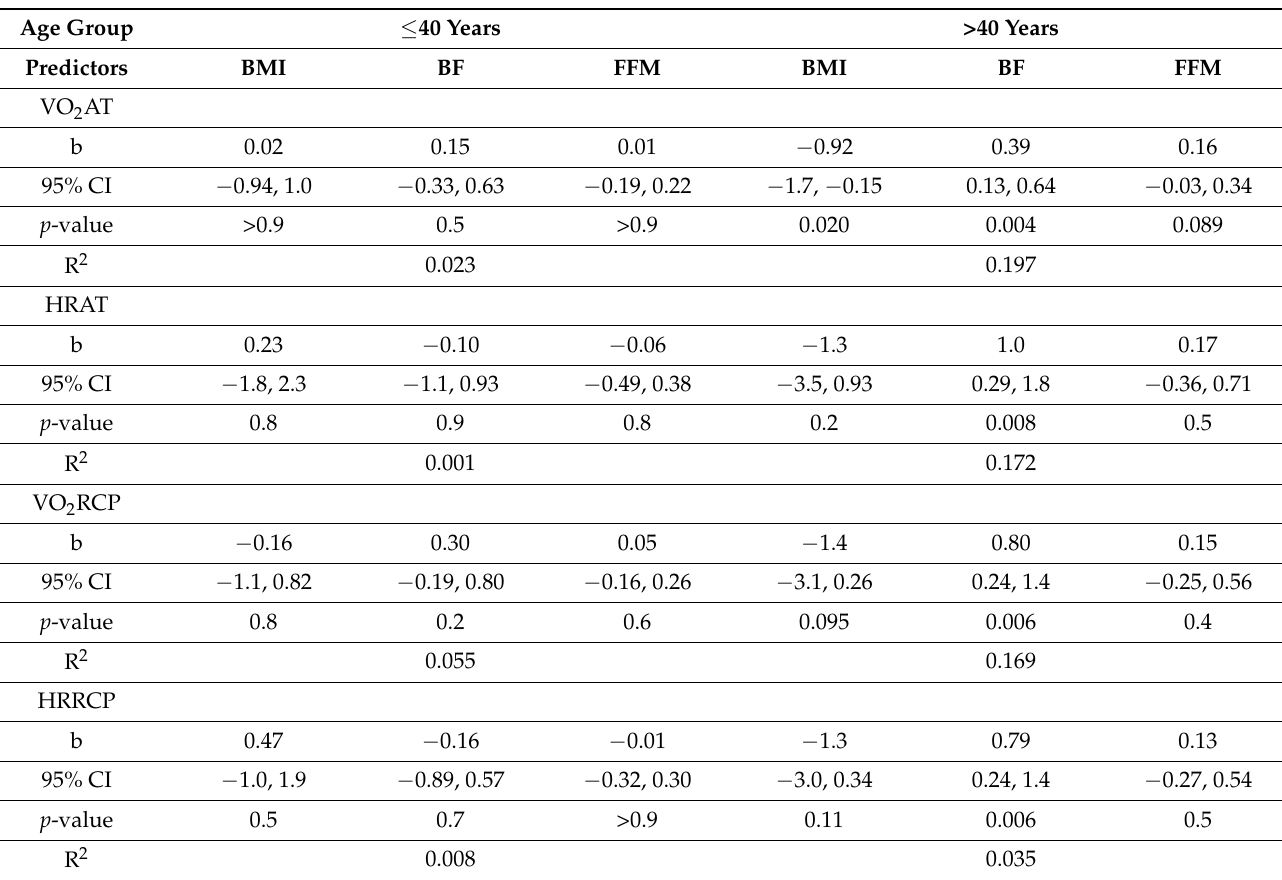
Table 7. Regression analysis for males in two subgroups ( ≤ 40 years and >40